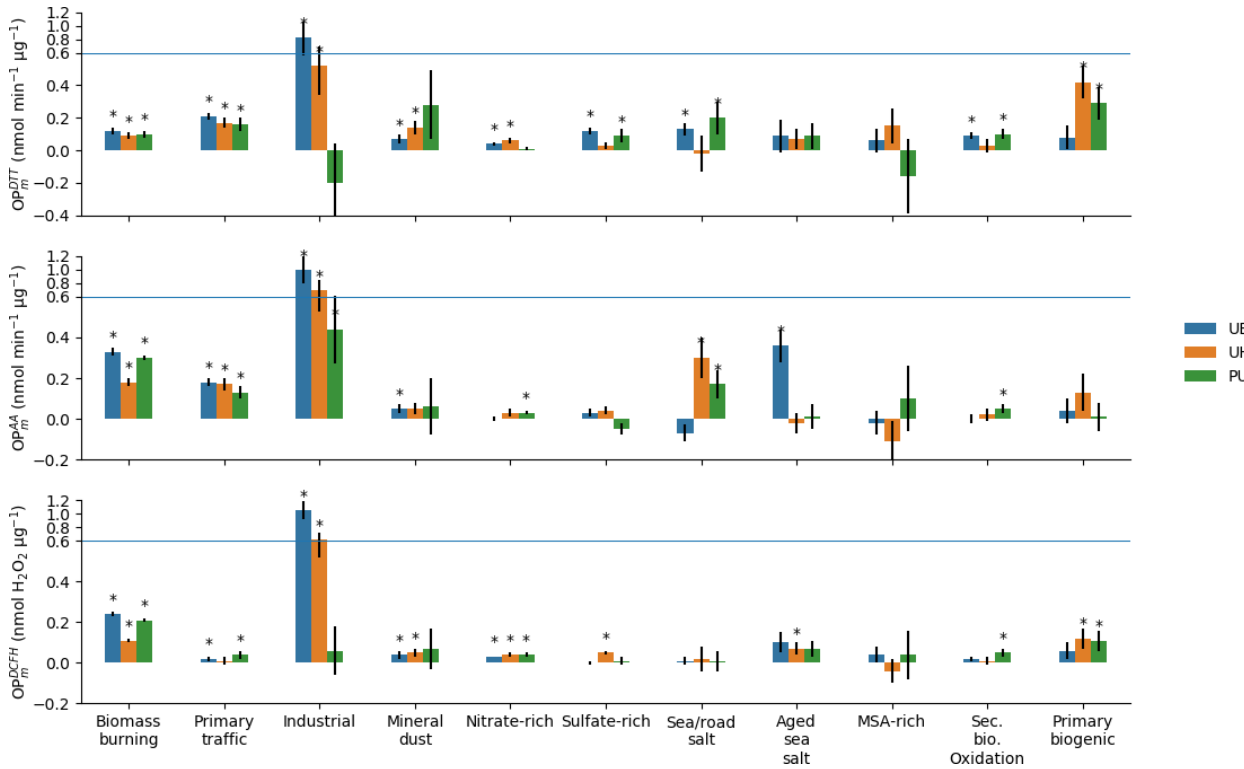
Figure 5. Site-specific intrinsic OP (OP m ) per source analysis from each assay (OP DTT m , OP AA m , and OP DCFH m ) represented by mean (bar) and standard deviation (error bar) based on the MLR (urban background, UB: blue, urban hyper-centre, UH: orange, peri-urban, PU: green). Note: asterisks represent statistically significant OP m within a 95% confidence interval ( p value ≤ 0 . 05).